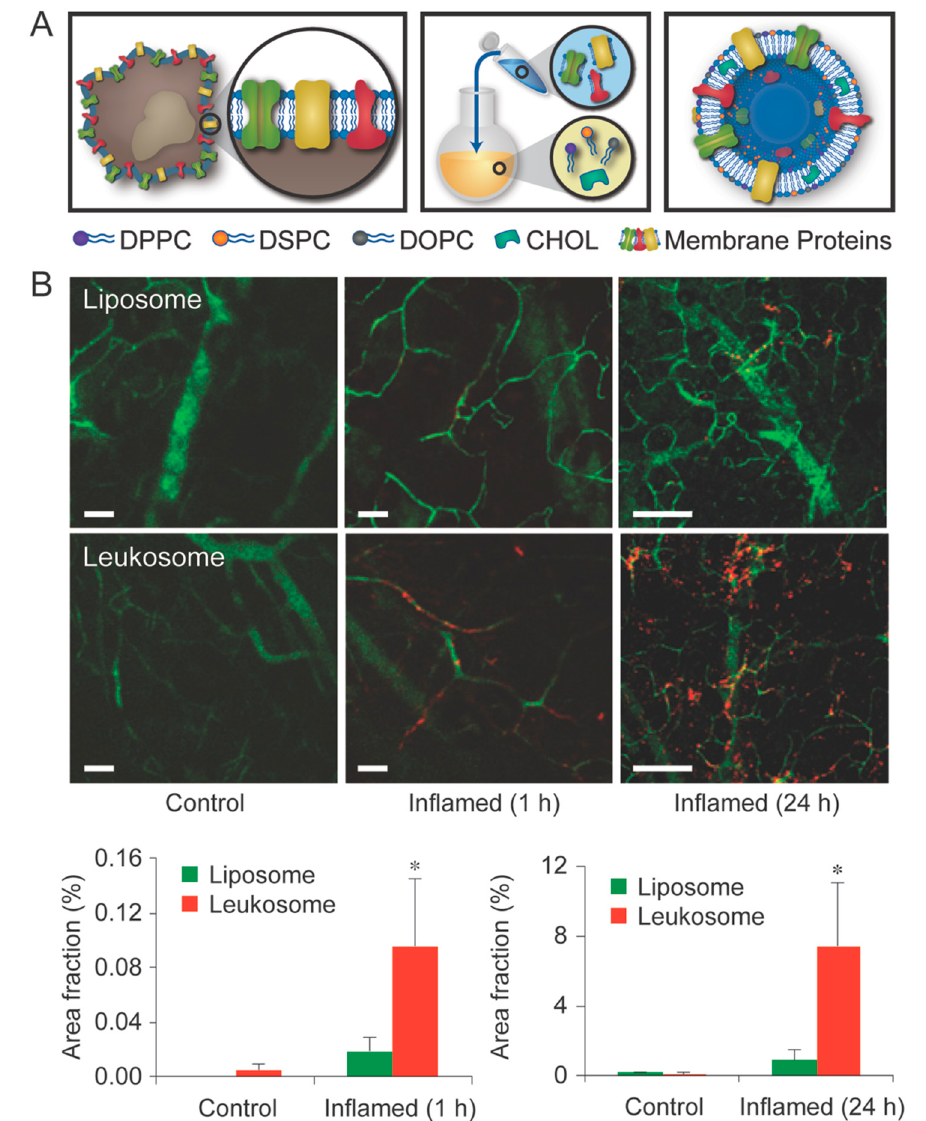
Figure 5. ( A ) Schematic illustration representing the synthesis and formulation of leukosome nanoparticles. ( B ) Intravital microscope images comparing liposome and leukosome accumulation in a lipopolysaccharide-inflamed mouse ear at 1 h and 24 h. Quantitative analysis was performed by calculating the area fraction covered by nanoparticles. Error bars represent the mean  SD of a minimum of ten fields of view from three mice. Images reproduced from [123], with permission from Springer Nature,